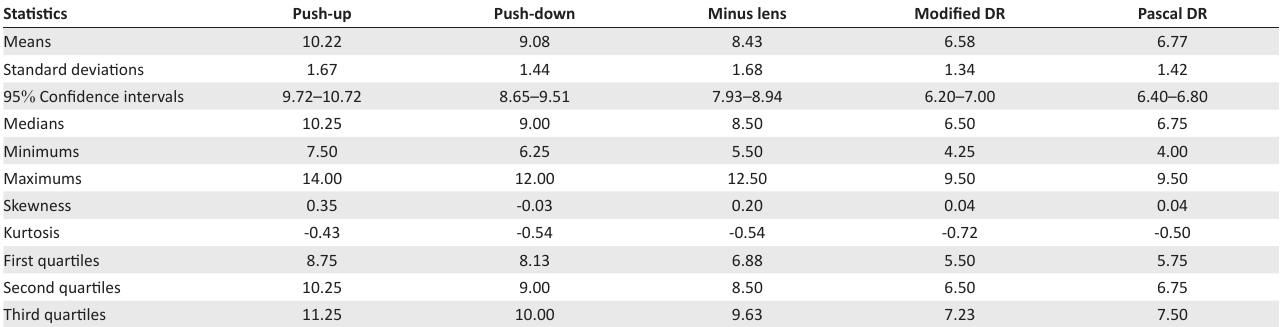
TABLE 1: Descriptive statistics of the measurements of the amplitude of accommodation using the push-up, push-down, minus lens, modified dynamic retinoscopy and Pascal dynamic retinoscopy methods. Statistics